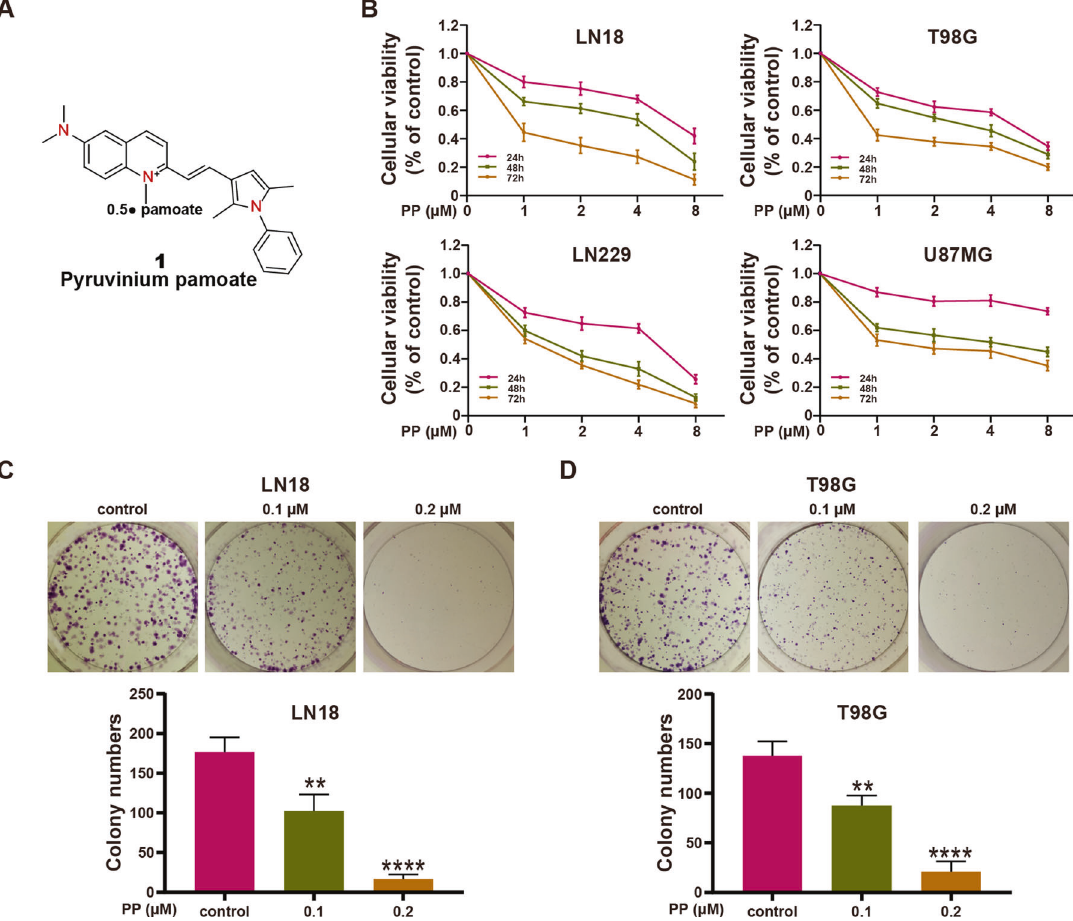
Fig. 1 PP inhibited the viability and colony forming capacity in GBM cells. A PP chemical structure. B PP (0 – 8 μ M) was used to treat the LN18, T98G, LN229, and U87MG GBM cell lines for 24, 48, and 72 h; then, MTT assay was conducted to detect cell viability ( n = 3). C , D LN18 ( C ) and T98G ( D ) cells were subjected to PP treatment for 10 days. Later, the colonies formed were photographed and counted, as displayed in the histogram ( n = 3). The results were presented in the manner of mean ± SD. Compared with control group, ** p < 0.01; **** p <